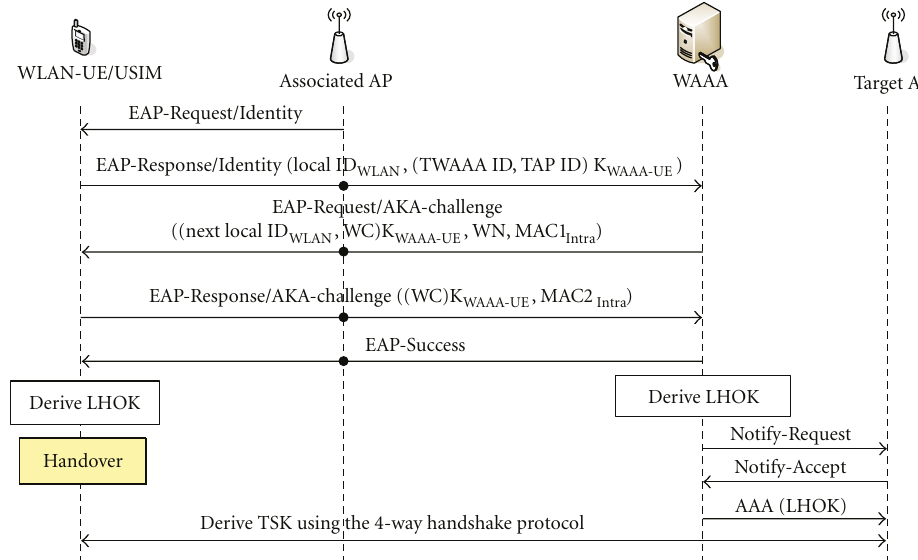
Figure 4: Intra-WLAN Fast Pre-authentication